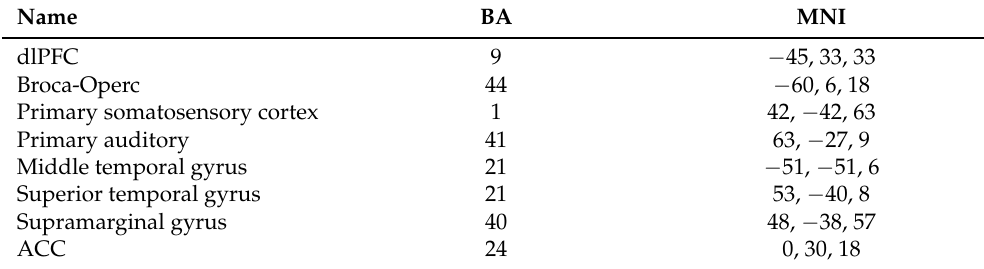
Table 1. Peak activations in the t -maps of the resting-state networks that show group